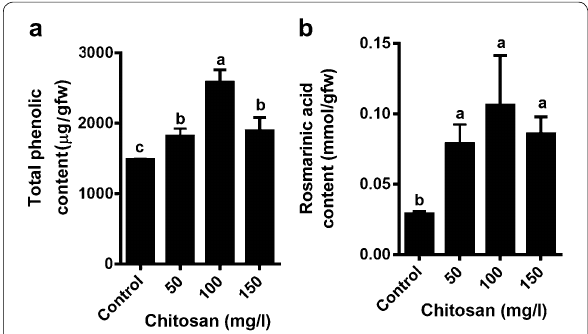
Fig. 4 Effect of chitosan levels on total phenolic compound ( a ) and rosmarinic acid ( b ) of Melissa officinalis shoot cultures. Each value is